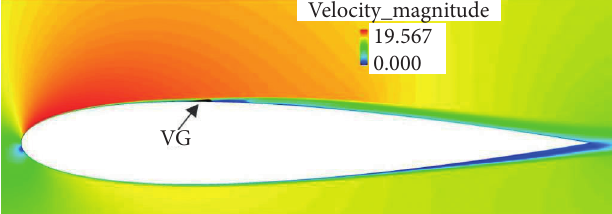
Figure 10. Velocity profile on NACA 0015 airfoil with VG in Plane 3 in Re c = 2.38 × 10 5 and AoA = 3.